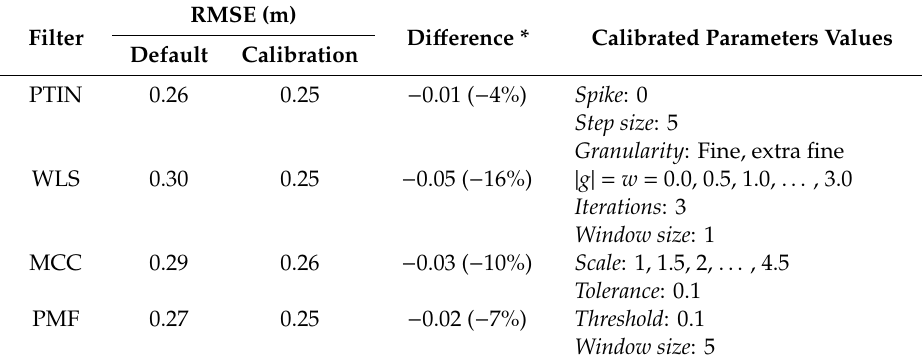
Table 4. Root mean square error (RMSE) of the digital terrain models (DTMs) derived by the default and the calibrated parameter values for progressive triangulated irregular network (PTIN), weighted linear least-squares interpolation (WLS), multiscale curvature classification (MCC), and progressive morphological filter